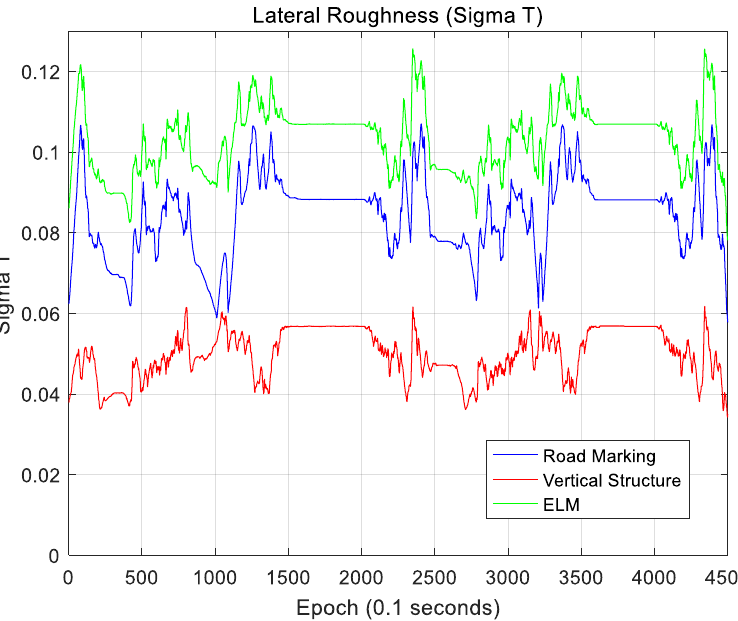
Figure 35. Lateral roughness (Sigma-T).